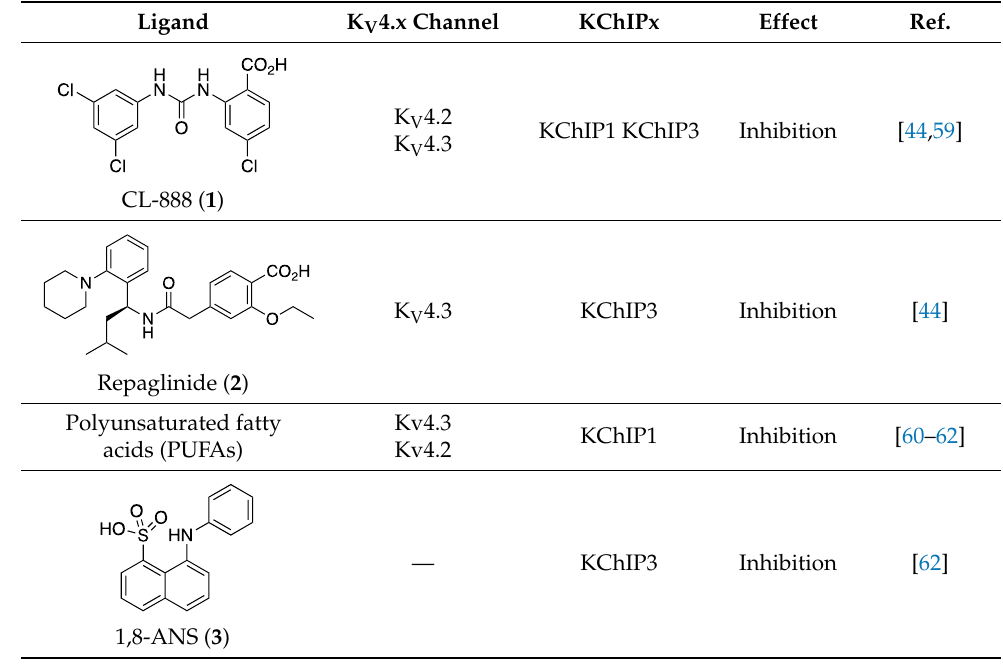
Table 1. Known small-molecule K V 4.x/KChIP modulators.